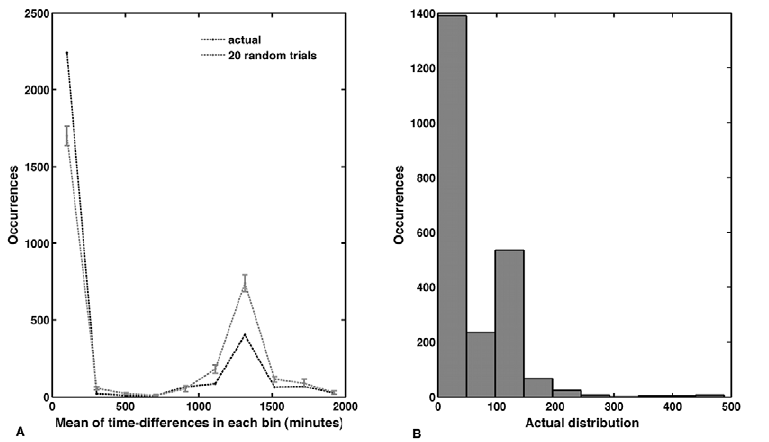
Figure 2. Time difference in births of connected neurons. Most connected neurons are born temporally close to each other with approximately half of them appearing within 50 minutes of each other. Comparison shows that similar findings cannot be expected from random growth. (A) Mean of birth-time-differences of all pairs of connected neurons plotted against the frequency within each time interval. Mean of time- differences refers to the mean of the time differences within each bin. Curves show the actual network compared to average values and standard deviations from twenty random networks. (B) The actual distribution of the birth-time-differences within the first ten bins giving a more detailed picture of the most prevalent birth-time-differences between connected neurons. The first 50 minutes bin has the highest frequency at approximately 1400. Thus around 1400 connected neurons ( , half of all connection-pairs) form within 50 minutes of each other.